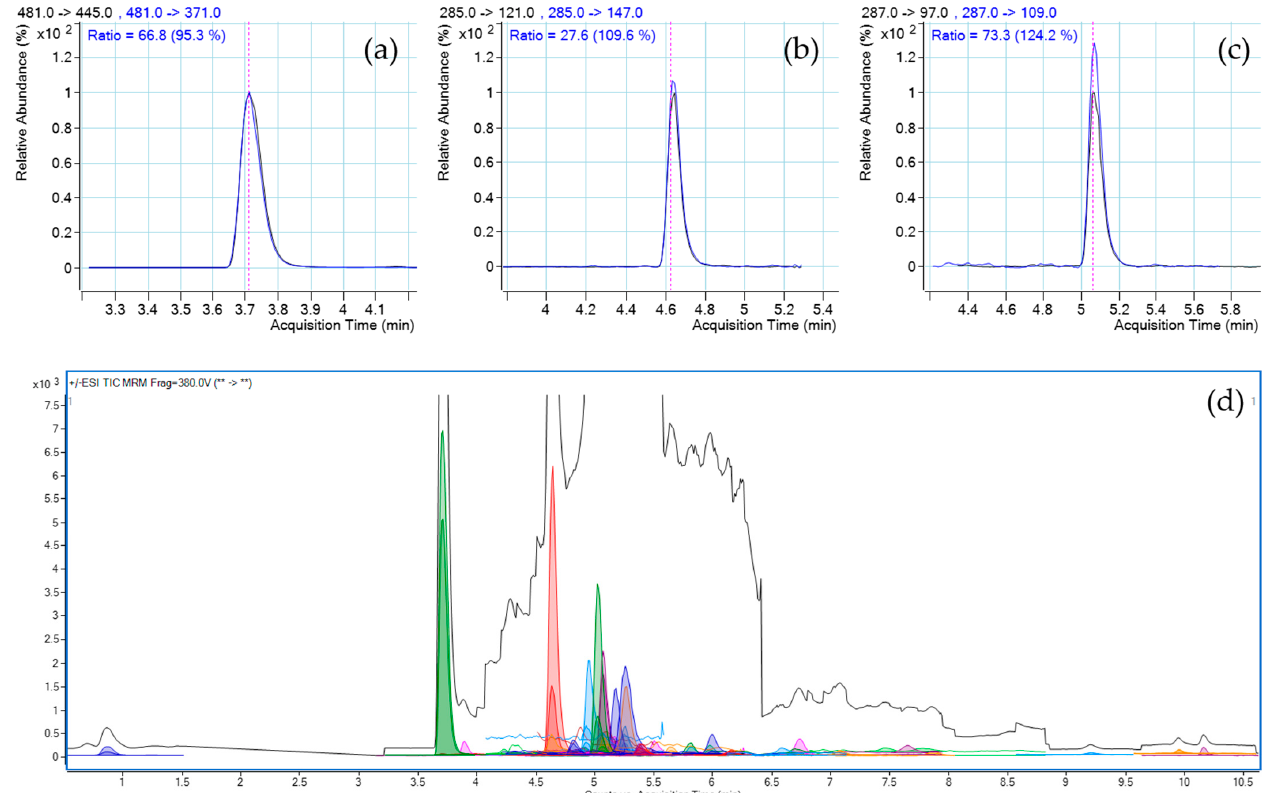
Figure 2. LC-MS/MS chromatograms of sample “J1”. ( a – c ) MRM transitions and ratios of ECD, 1,4-androstene-3,17-dione and 4(5)-androstene-3,17-dione, respectively, in sample blank. ( d ) TIC chromatogram and dMRM chromatogram of sample spiked at RL concentration of the mixture of 47 prohibited substances and ECD.